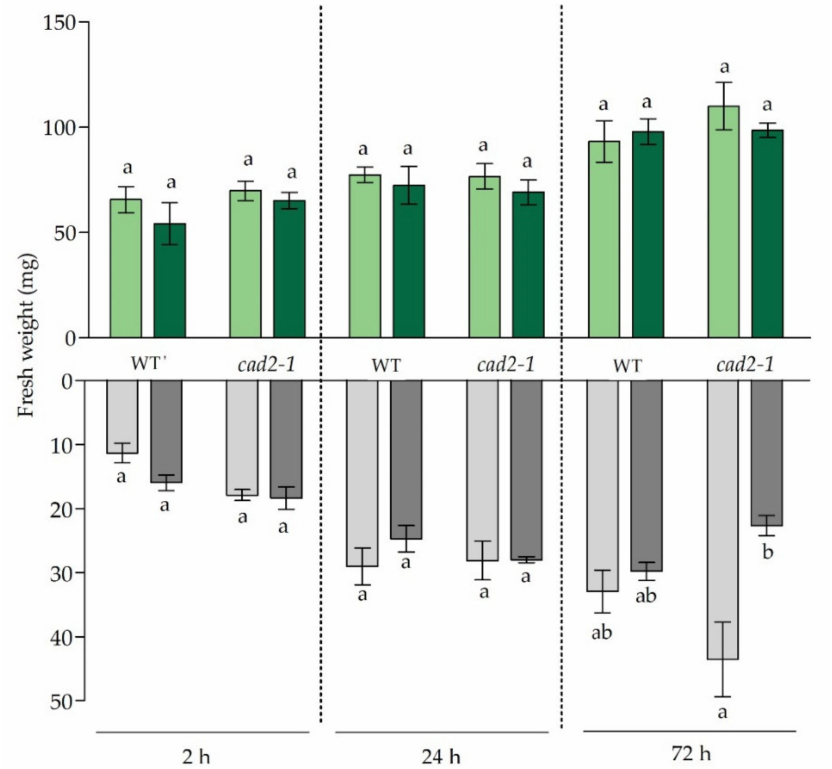
Figure 1. Rosette (green bars) and root (grey bars) fresh weight (mg) of 3-week-old wild-type (WT) and cad2-1 mutant Arabidopsis thaliana plants grown under control conditions (0 µ M CdSO 4 , light bars) or exposed to 5 µ M CdSO 4 (dark bars) during 2 h, 24 h, and 72 h. Data are presented as the mean ± S.E. of at least eight biological independent replicates. Significant differences (2-way ANOVA: p < 0.05) within each time point and organ are indicated with different